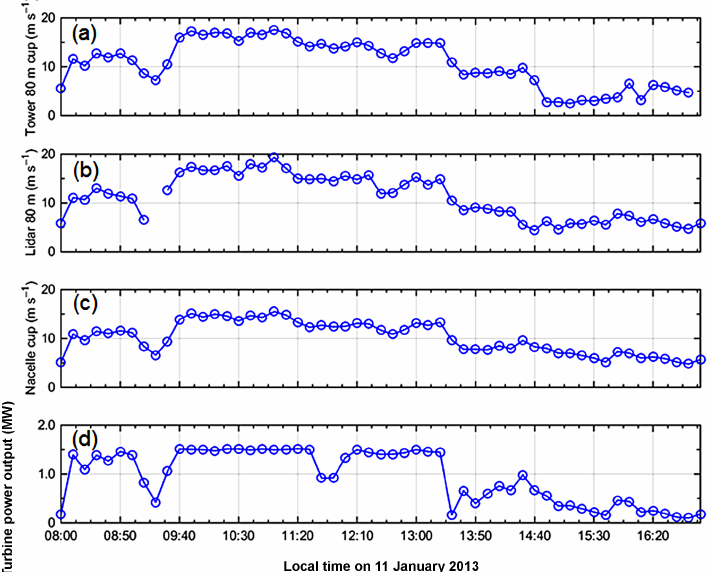
Figure 3. Time series from 11 January 2013 from 08:00 to 17:00MST (Mountain Standard Time): (a) is a time series of 80m wind speeds measured by the cup on the tower, (b) is a time series of 80m wind speeds measured by the lidar, (c) is a time series of the hub-height wind speeds measured by the cup anemometer on the nacelle, and (d) is a time series of the power output from the